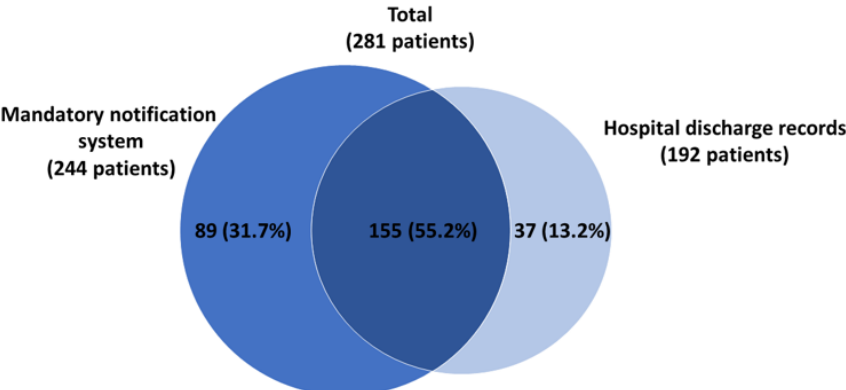
Figure 4. Venn diagram showing the number and percentage of cases of TBE identified by 2 sources: the MNS and HDRs in Veneto from 2007 to 2018. MNS, mandatory notification system; HDRs, hospital discharge records. (Adapted from ref.